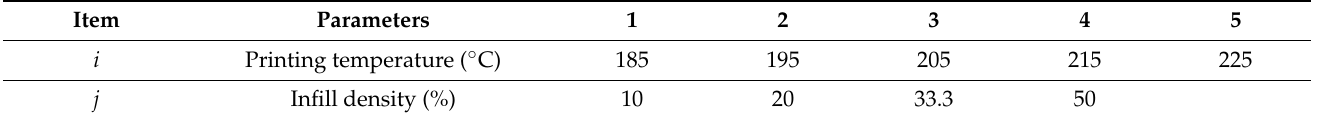
Table 5. The definition of number i and j of the change rate of the printing temperature and infill density respectively. Item